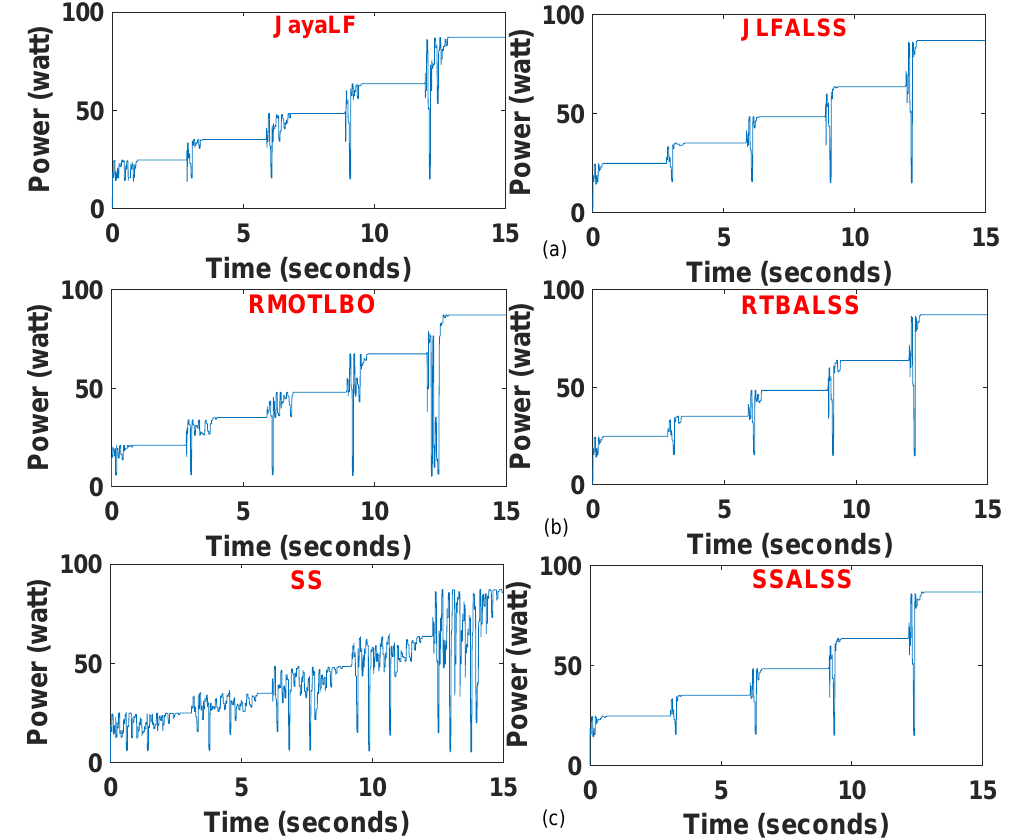
Figure 9. Comparison between ( a ) JayaLF and JLFALSS, ( b ) RMOTLBO and RTBALSS, and ( c ) SS and SSALSS for increasing dynamic